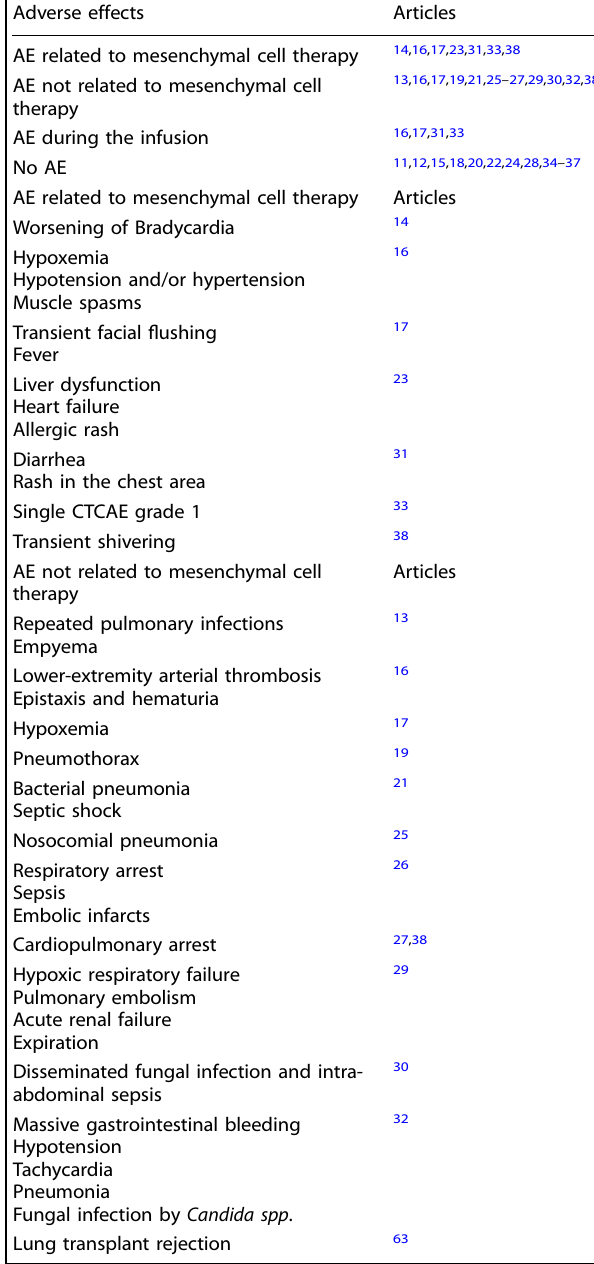
Table 4. Adverse